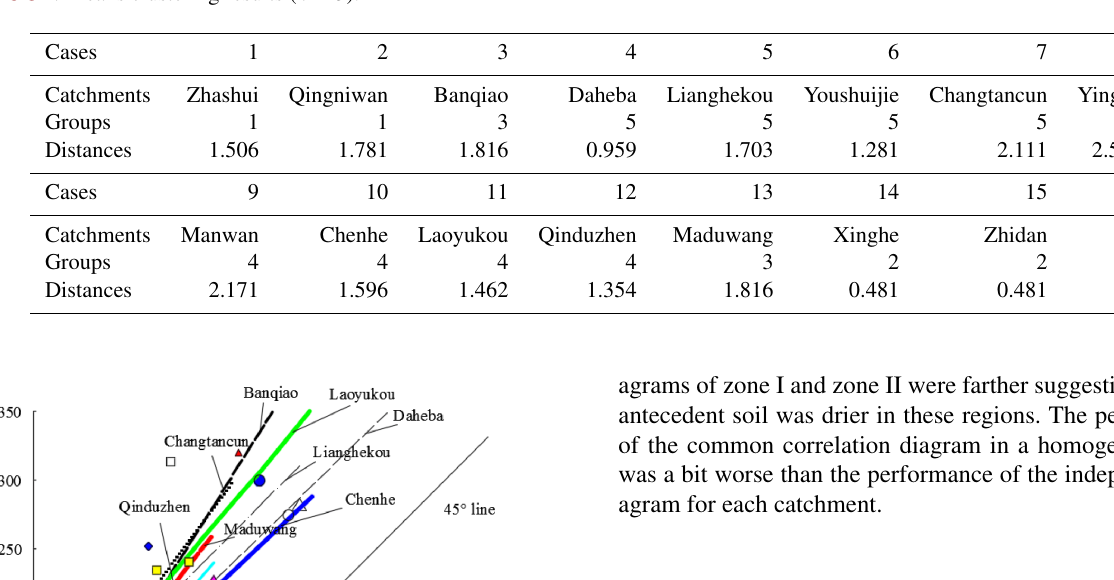
Table 3. k -means clustering results ( k = 5).